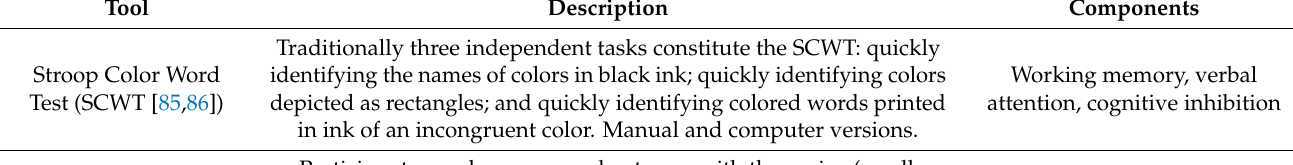
Table 3. Description of traditional neuropsychological tools used to assess executive functions in schizophrenia.